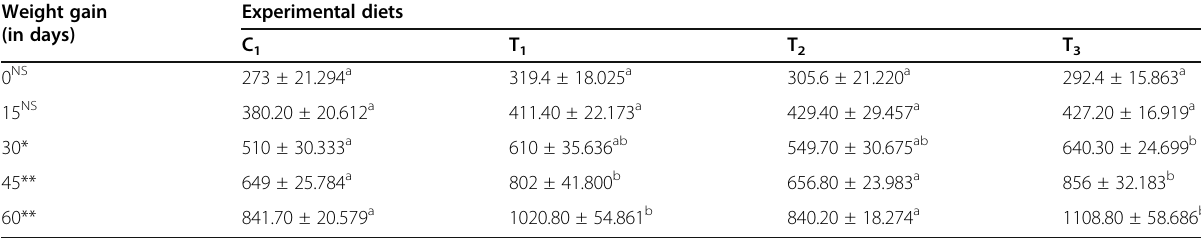
Table 4 Effect of seaweed ( Ulva lactuca ) and Azolla feed supplement on weight gain of Aseel chicken Weight gain (in